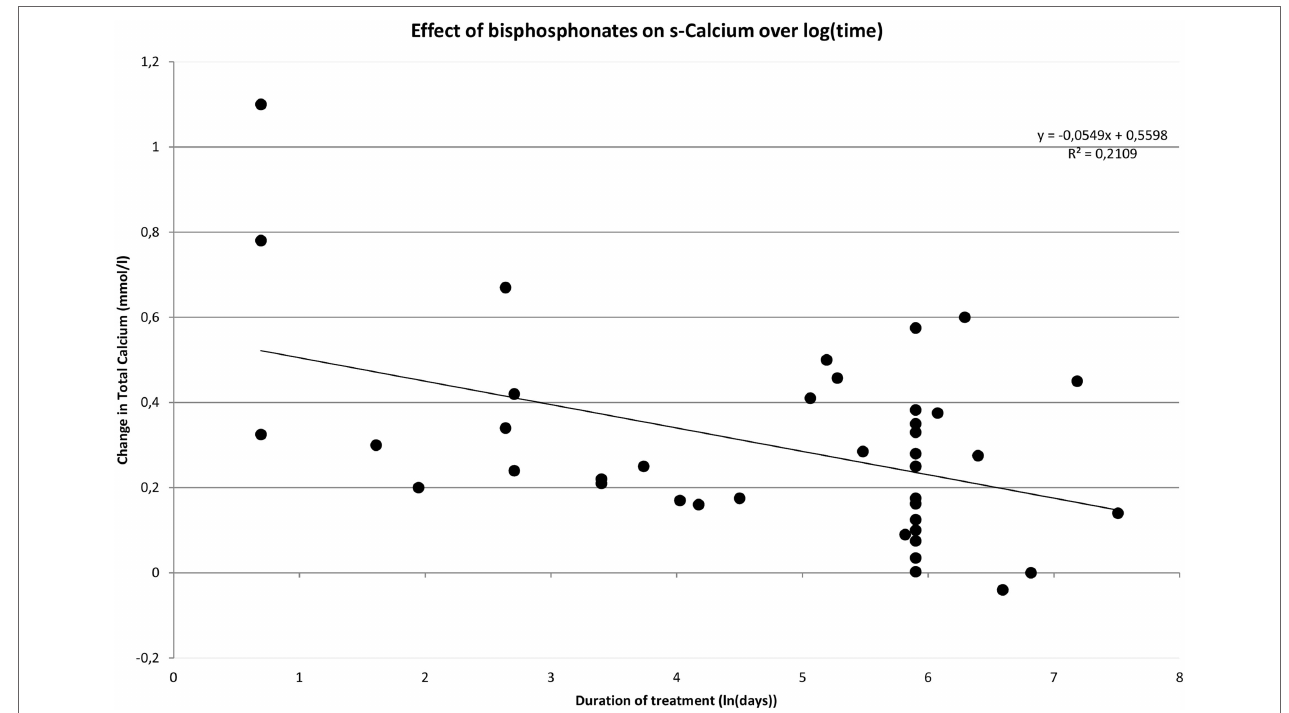
FiGURe 3 | effect of bisphosphonates over time logarithmically transformed